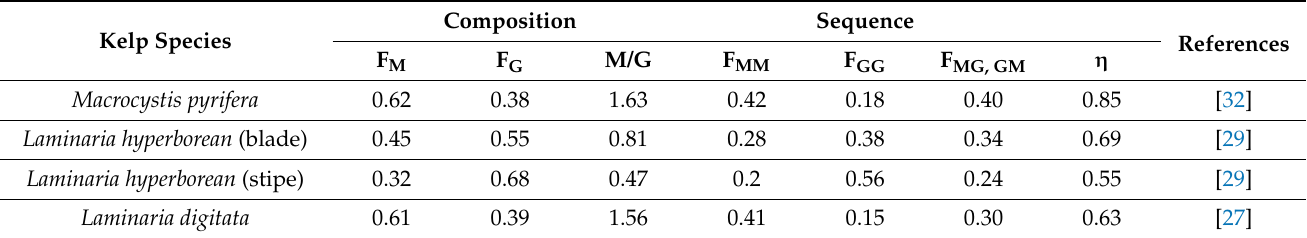
Table 3. Composition data of alginates from the blades and stipes of the studied kelps L. ochroleuca and S. polyshides in comparison with the main kelp